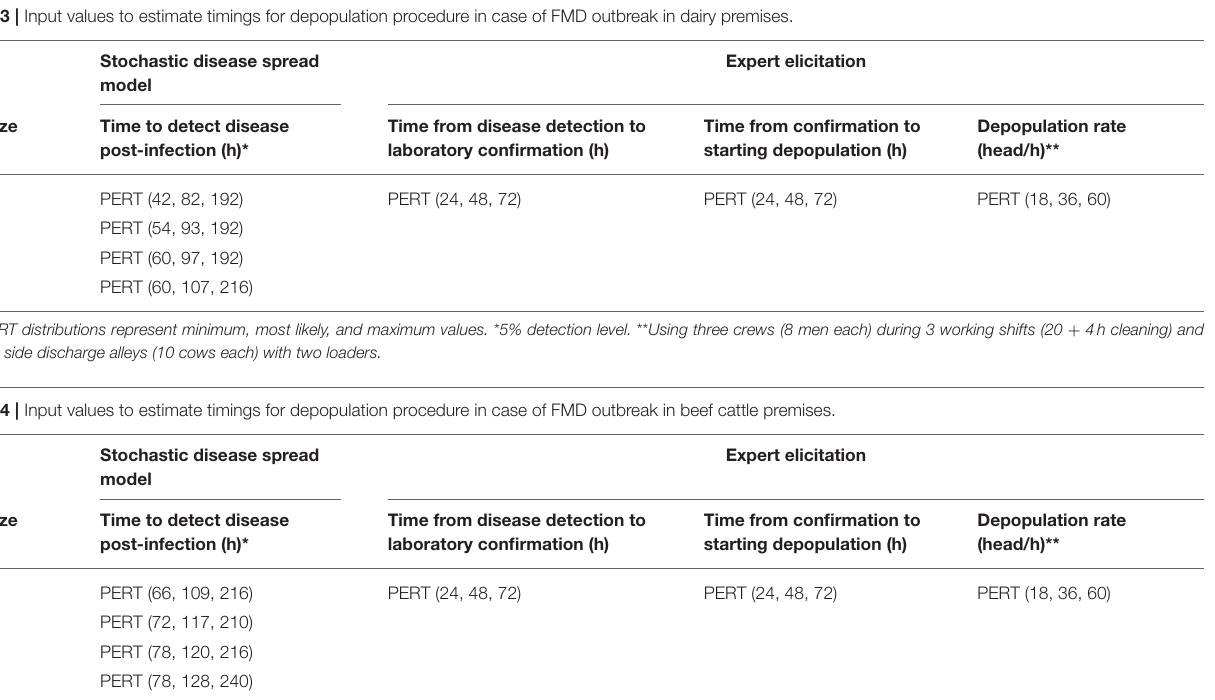
TABLE 3 | Input values to estimate timings for depopulation procedure in case of FMD outbreak in dairy premises. Stochastic disease spread model